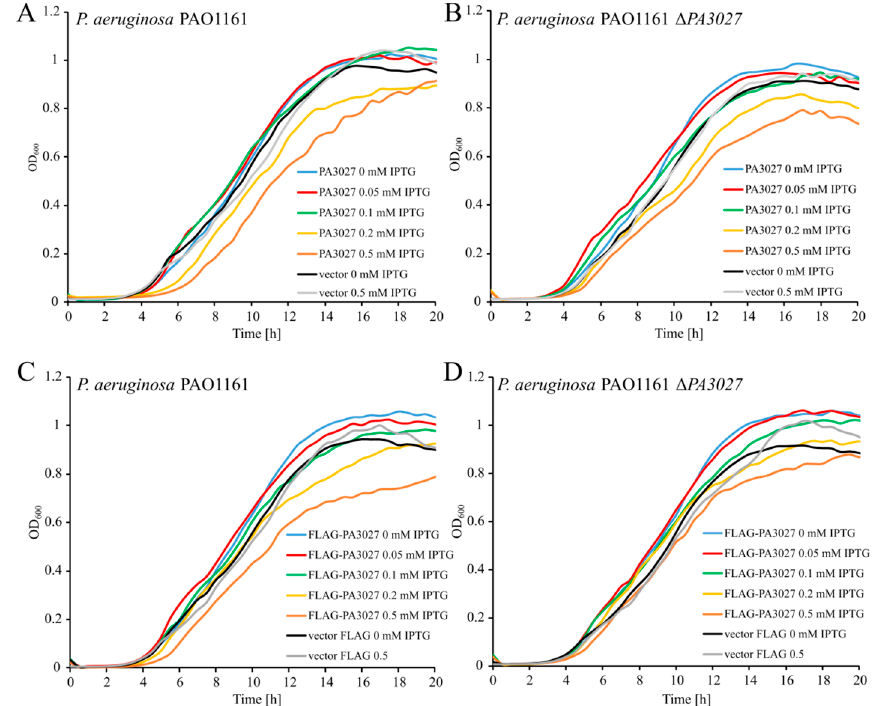
Figure A1. Impact of PA3027 excess on the growth of P. aeruginosa PAO1161. PAO1161 or ∆ PA3027 mutant strains carrying empty vector pAMB9.37 tac p or pKKB1.11- tac p- PA3027 ( A , B ) or empty vector tac p– flag or pKKB1.12 tac p– flag – PA3027 ( C , D ) were grown in L-broth under selection with the indicated concentration of inducer IPTG (0.05–0.5 mM). The red line indicates the growth in the presence of 0.05 mM IPTG, conditions selected for RNA-seq analysis. Data represent mean OD 600 from three independent replicates. Standard deviations are not shown for